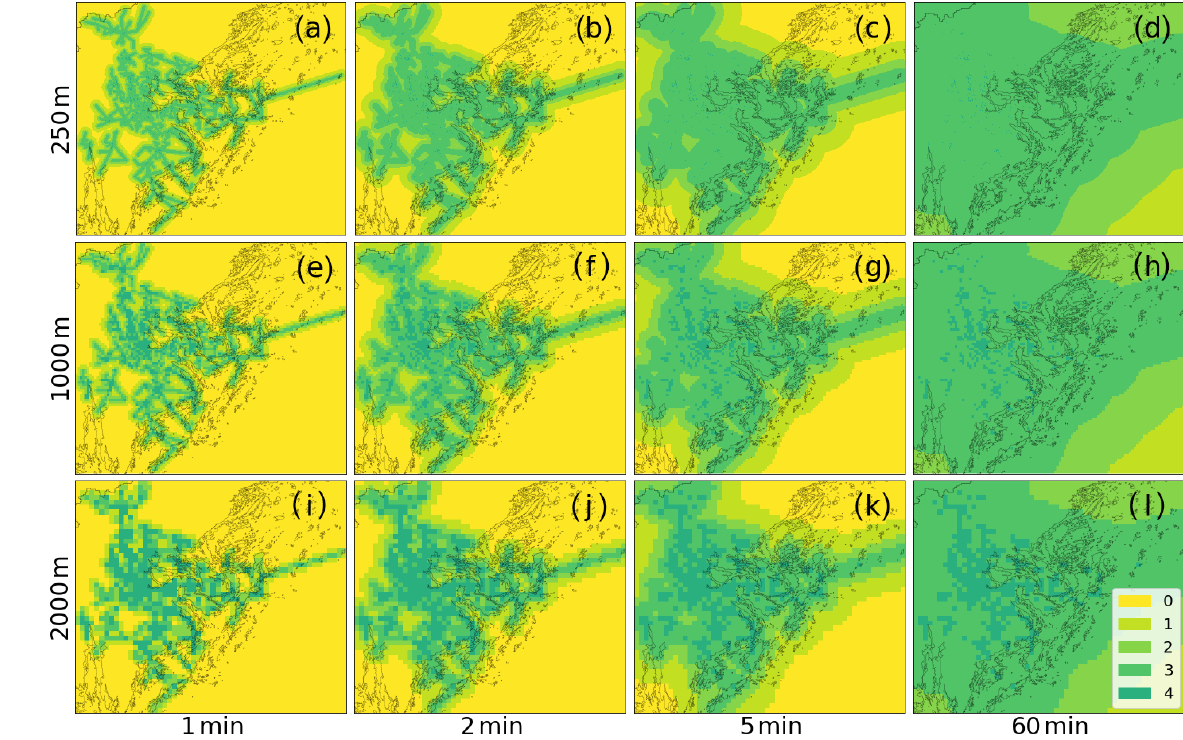
Figure 3. Map of the attainable quality for different temporal and spatial resolutions using a variogram for southern Sweden in a summer situation (DOY 206), where the colors represent the quality levels equal to Fig. 1a and b. The columns represent the accumulation time (1, 2, 5, 60min) and the rows the spatial resolution (250, 1000 and 2000m). The map covers the entire Stockholm area, i.e. the full extent of Fig. 2.